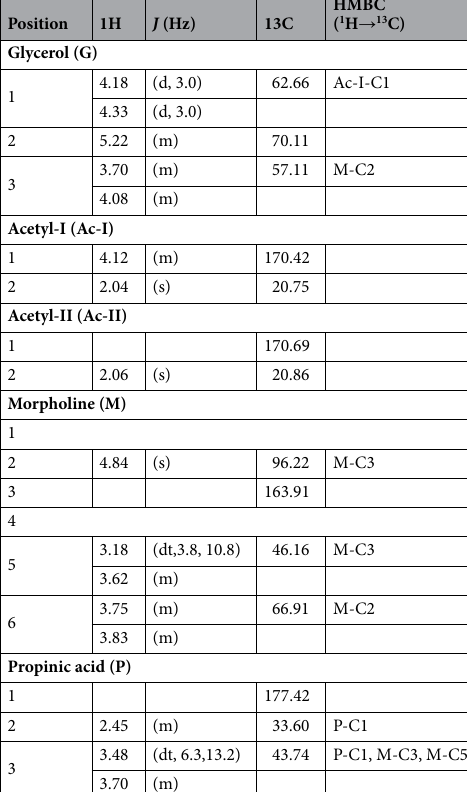
Table 4. 1 H-NMR and 13 C-NMR data for acetylated M-glyceride. Acetyl M-glyceride: 1,2-di-acetylglyceryl-2 ′ - oxy-3 ′ -oxomorpholino propionic acid. CDCl 3 was used as a solvent. Multiplets in Table 4 are due to overlapped peaks except G-2. dd doublet of doublet, s singlet, dt doublet of triplet, m